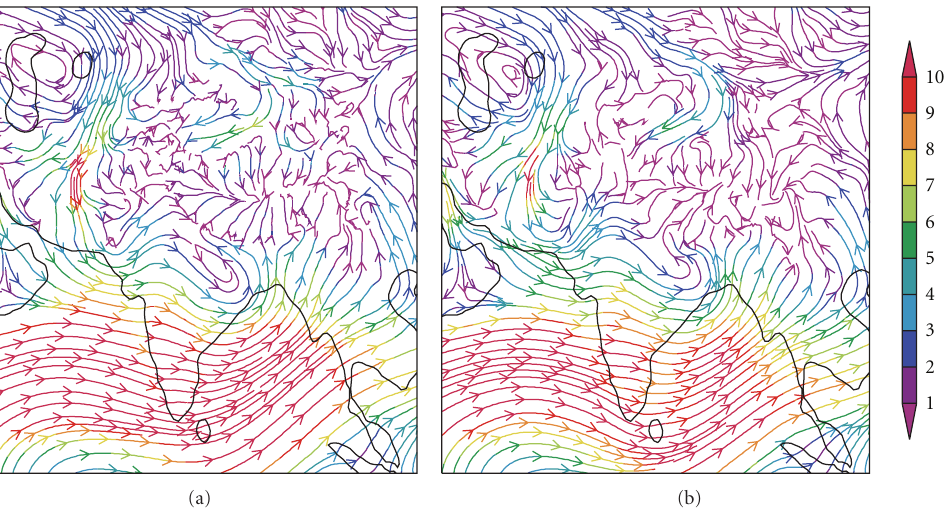
Figure 3: Mean wind fields (wind vectors) and wind speed at 850hPa (m/s; colours) for HIRHAM (a) and ERA40 (b); summer monsoon (JJAS)